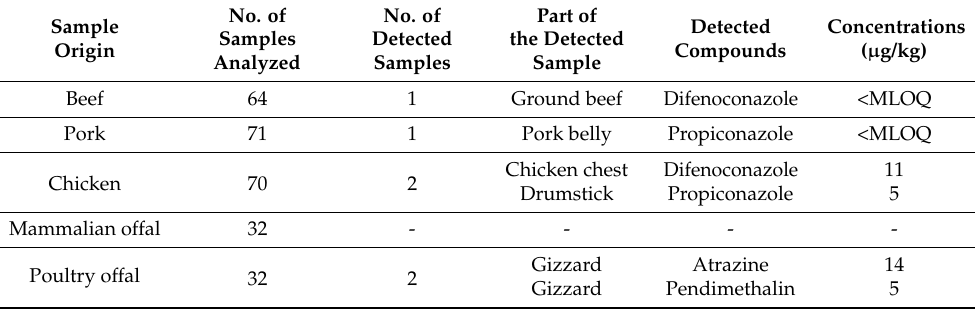
Table 2. A summary of monitoring of 32 analyzed compounds for 269 commercial meat products in Korea, by the developed method for the detected number and related pesticides and their respective concentrations.